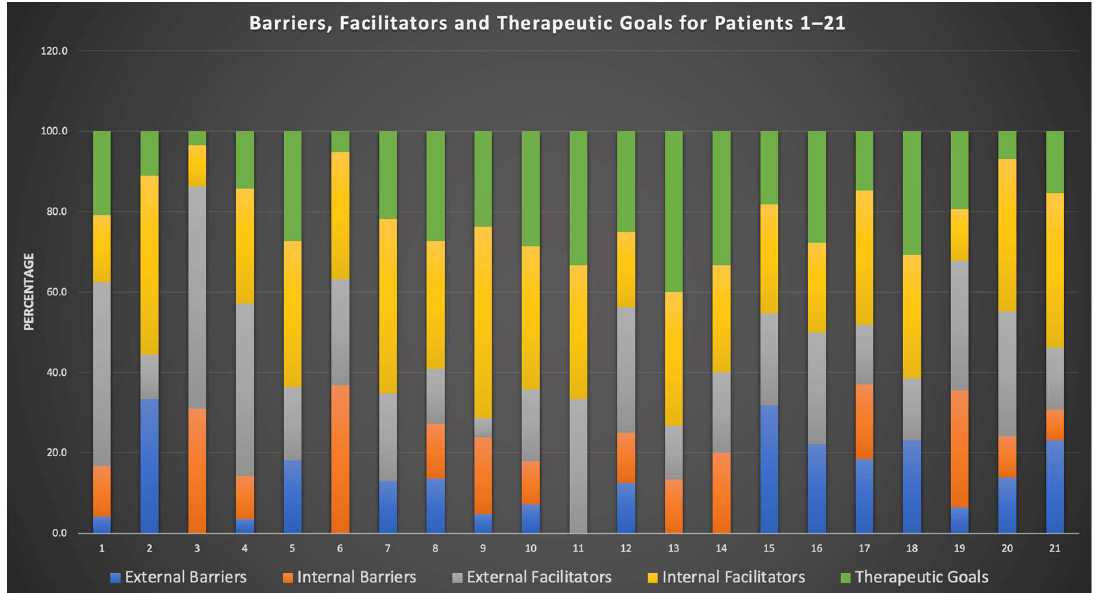
Figure 2. Relative distribution of external barriers, internal barriers, external facilitators, internal facilitators and psychotherapy goals for each case.